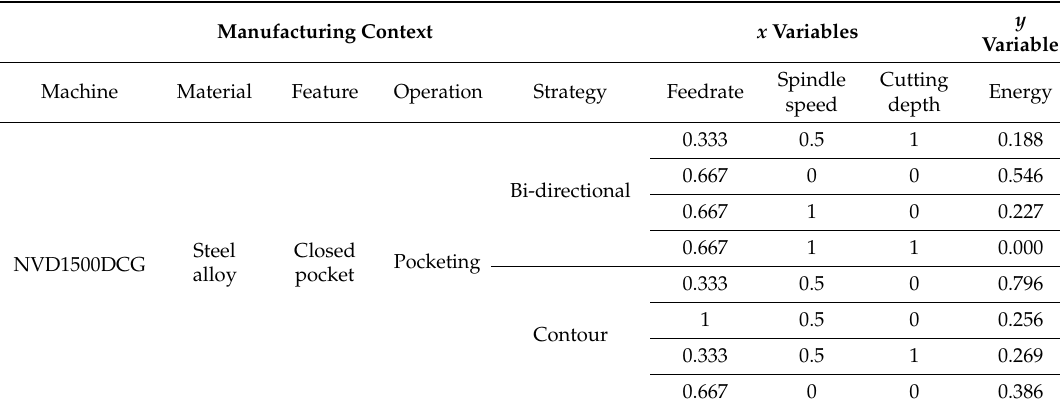
Table 3. An example of training datasets.